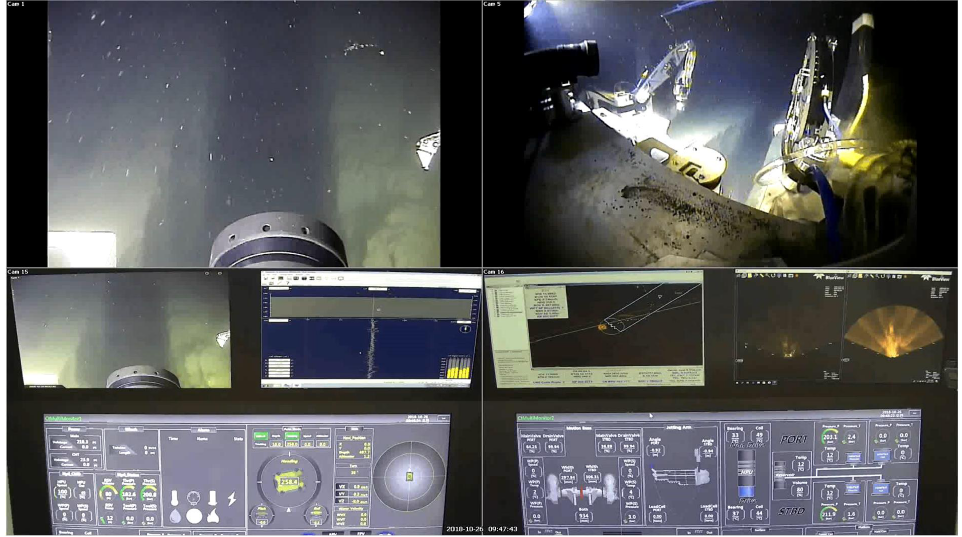
Figure 15. Post survey of cable burial tests.